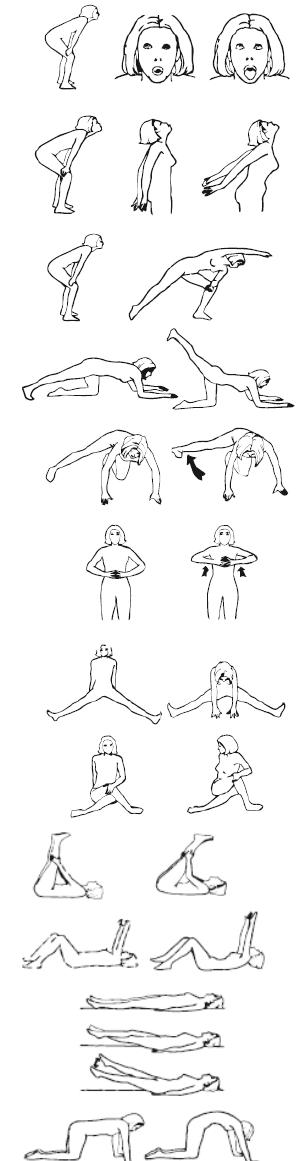
Fig. 2. Fulfillment of exercises “Body flex”, offered for group. Source: